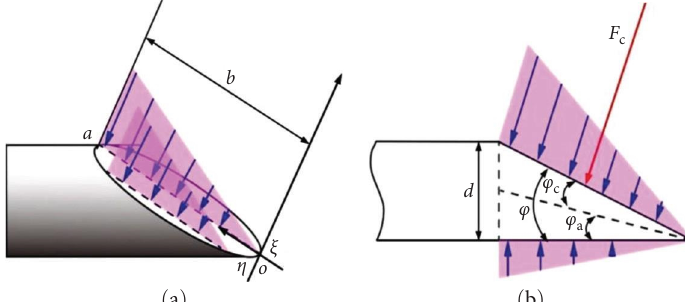
F IGURE 3: Diagram of force analysis of cutting force: (a) schematic diagram of the needle tip bevel; (b) schematic diagram of the side of the needle